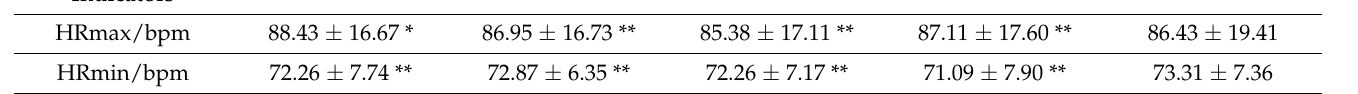
The data in the table are shown as mean ± standard deviation. * Indicates significance at a level of p < 0.05. ** Indicates significance at a level of p < 0.01. significance at a level of p < 0.01. significance at a level of p < 0.01. significance at a level of p < 0.01. significance at a level of p < 0.01.